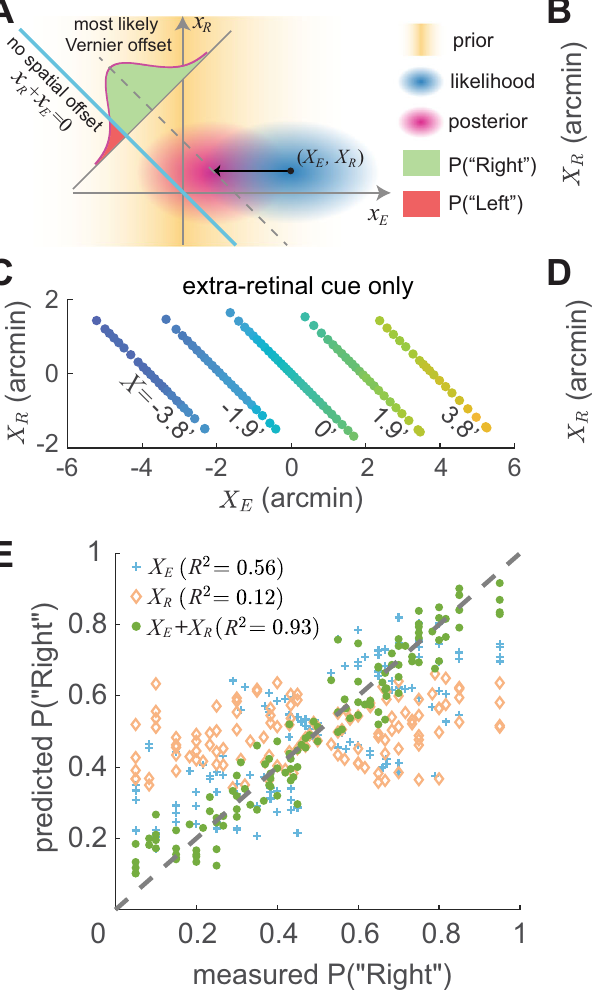
Fig. 3 | Integration of visual and motor cues. A An ideal observer model that B – D Responsepatternsarebestpredictedbythemodelwhencombiningbothcues combines retinal ( x R ) and extraretinal ( x E ) signals. The model assumes sensory ( B );the model ( C ) thatonly usesextraretinalinformation does not account forthe measurements to be corrupted by unbiased additive Gaussian noise (standard dependenceon X R ,andthemodel( D )thatusesonlyretinalinformation fi tspoorly. Graphic conventions are as in Fig. 2D. E , F Comparison of experimental data and deviations σ R and σ E ) and applies a uniform prior to x R and a zero-mean Gaussian ffiffiffiffiffiffiffiffiffiffi p model predictions of responses and d 0 : E Probability of responding “ Right ” for 2 DT , where T is the ISI), the latter based on the assumption that prior to x E ( σ = ocular drift resembles Brownian motion. In each trial, the likelihood of any given various combinations of X R and X E (the same data points as in B – D ). F Average performancemeasuredasd 0 ( N =7subjects).Errorbarsrepresent±oneSEMacross combination( X E , X R )is fi rstconvertedintoajointposteriorprobabilitydistribution and then integrated on the − 45 ∘ line x E + x R = X (dashed line) to evaluate the prob- subjects. The cue integration model predicts both subject responses and overall ability of any given Vernier offset X . The left/right perceptual report in a trial is performancewithsigni fi cantlygreateraccuracythanthesingle-cuemodels.Source determinedbywhichsideofthezero-offsetline(cyanline)giveshigherprobability. data are provided as a Source data fi